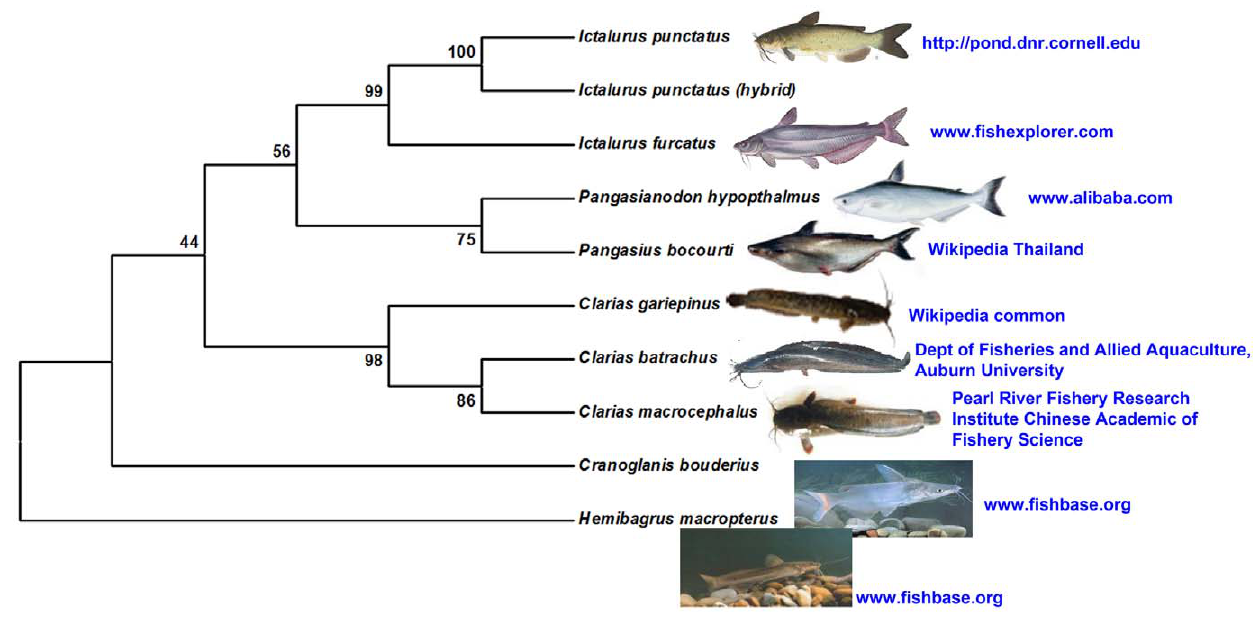
Figure 1. Phylogenetic consensus tree of nine catfish species (and an Ictalurid hybrid) constructed using Maximum Parsimony (MP) Method. The percentage of replicate trees in which the associated taxa clustered together in the bootstrap test (1000 replicates) is shown next to the branches [21]. Hemibagrus macropterus was used as an outgroup. The MP tree was obtained using the Close-Neighbor-Interchange algorithm [20] with search level 1 in which the initial trees were obtained with the random addition of sequences (10 replicates). The source for each image was displayed next to the pictures. doi:10.1371/journal.pone.0017812.g001 PLoS ONE |